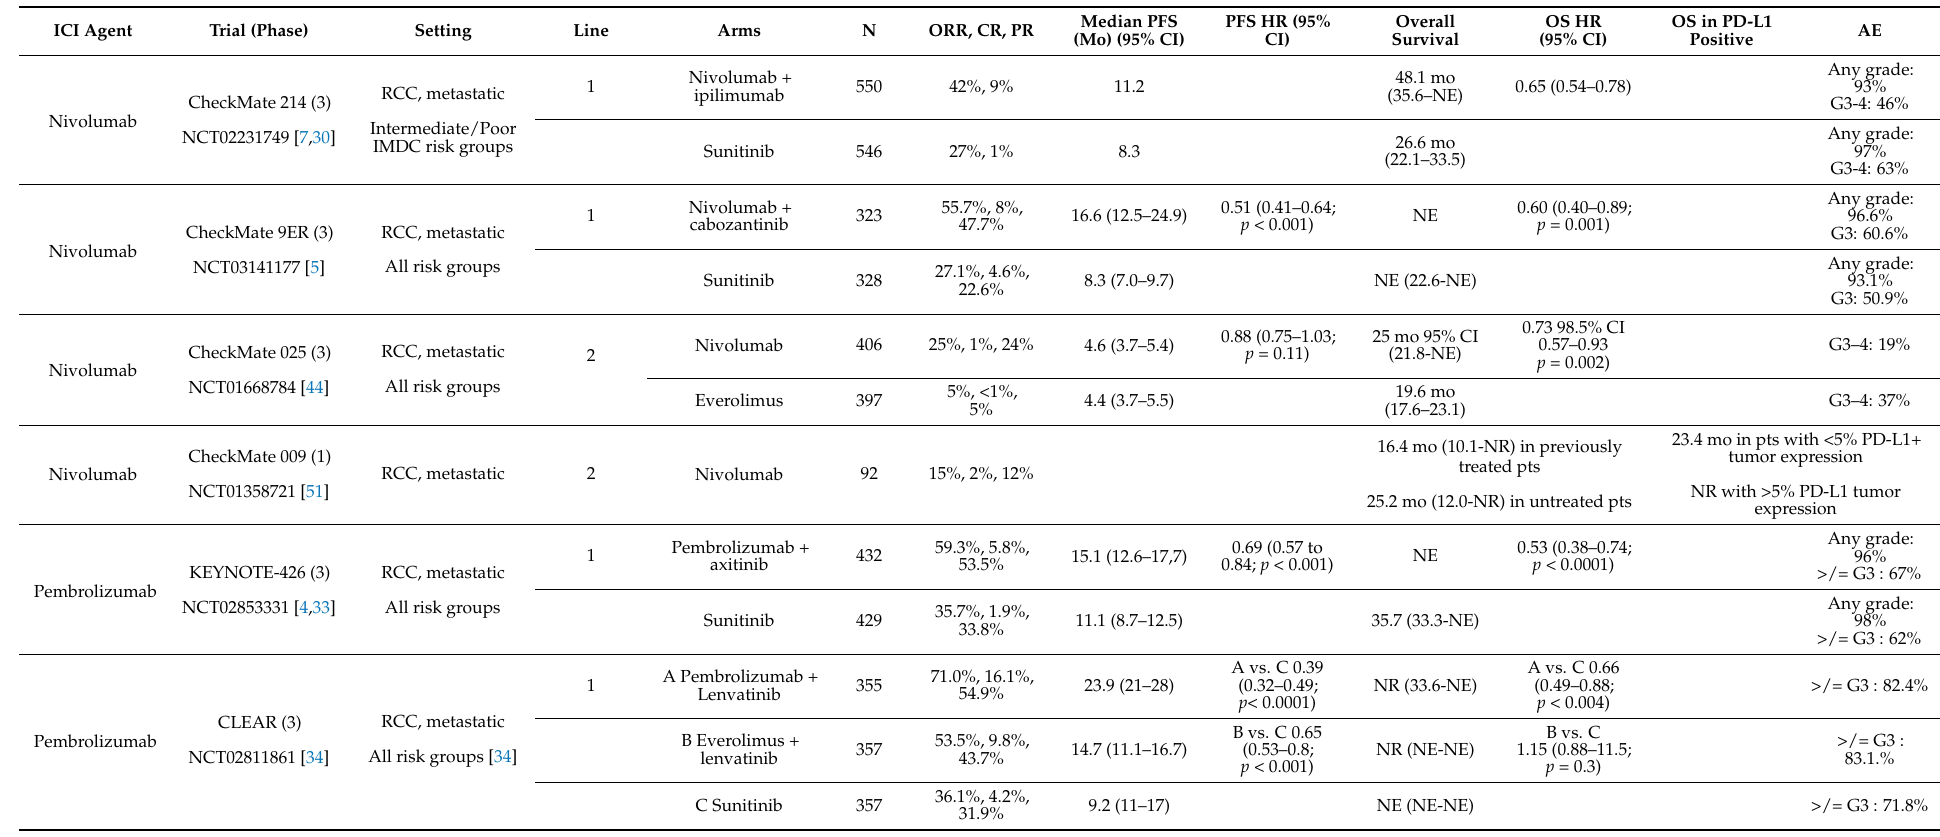
Table 2. ICI clinical trials in renal cell